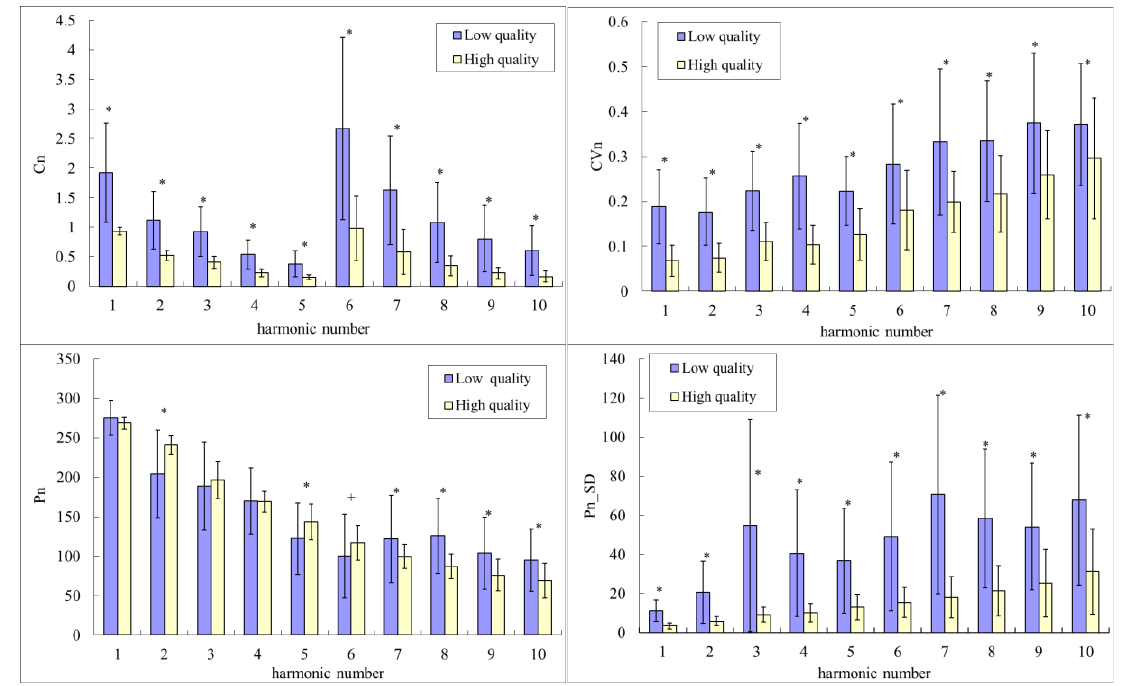
Figure 4. Comparisons of harmonic indices between Data A (high quality) and Data B (low quality): C n , CV n , P n , and P n _ SD . Data are mean and standard-deviation values. C 6 – C 10 values have been multiplied by 10 to make the differences clearer. “ * ” indicates p < 0.05. “+” indicates 0.05 < p < 0.1. C n , CV n , and P n _ SD were all significantly larger for Data B than for Data A. Regarding phase-angle indices, there were significant differences in P 2 , P 5 , and P 7 – P 10.